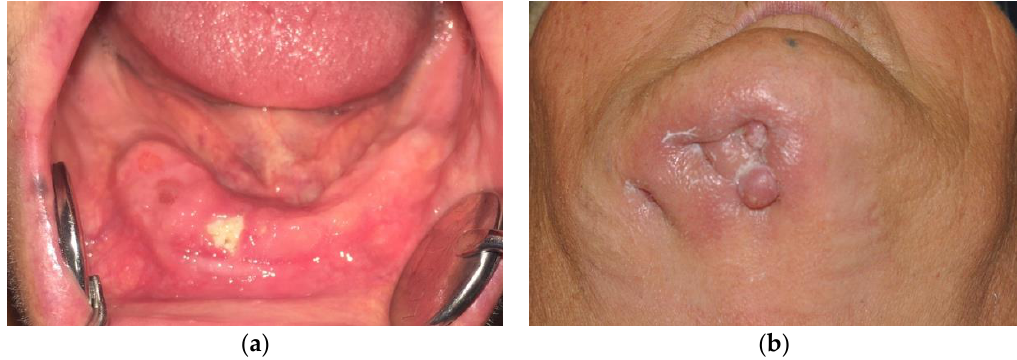
Figure 1. Typical signs of osteonecrosis. ( a ) Oral bone exposure; ( b ) cutaneous fistula .